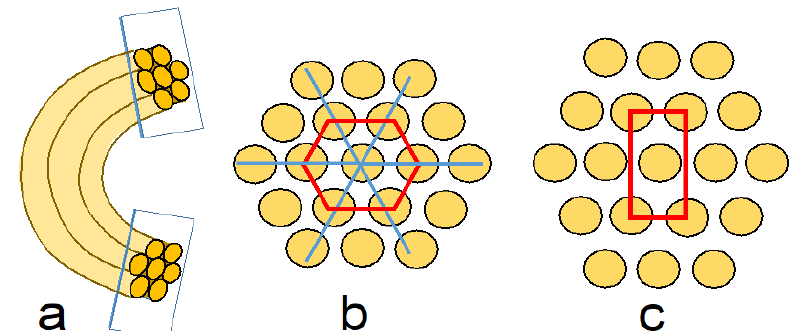
Figure 6. Isometric and equidistant structures in three dimensions. ( a ) A fragment of a developable domain structure, where all columns are curved in arcs of circles, but not splayed or twisted, and where the distribution of columns in any perpendicular plane shows the same hexagonal lattice of column axes. If the hexagonal distribution shown in ( b ) is distorted, for example into a centred rectangular lattice, as shown in ( c ), the structure becomes equidistant, but is no longer isometric. Redrawn from Atkinson et al. [19].